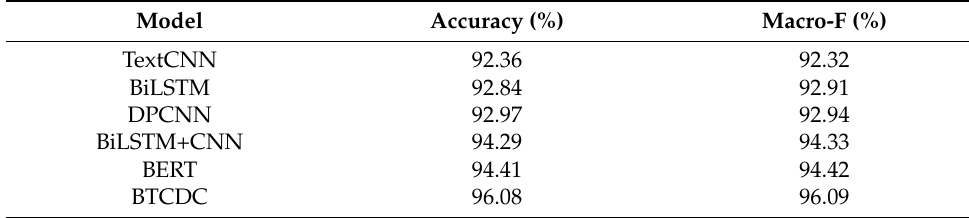
Table 4. Experimental results on Sohu News dataset.